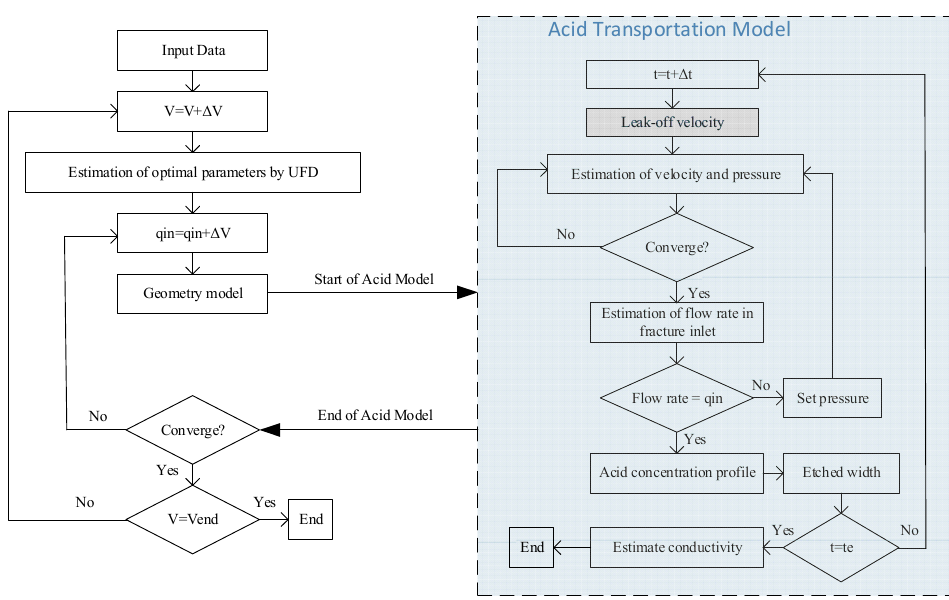
Figure 1. Flowchart of the proposed method.